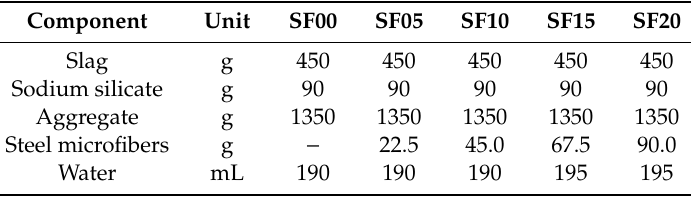
Table 1. Composition of alkali-activated slag mixtures.